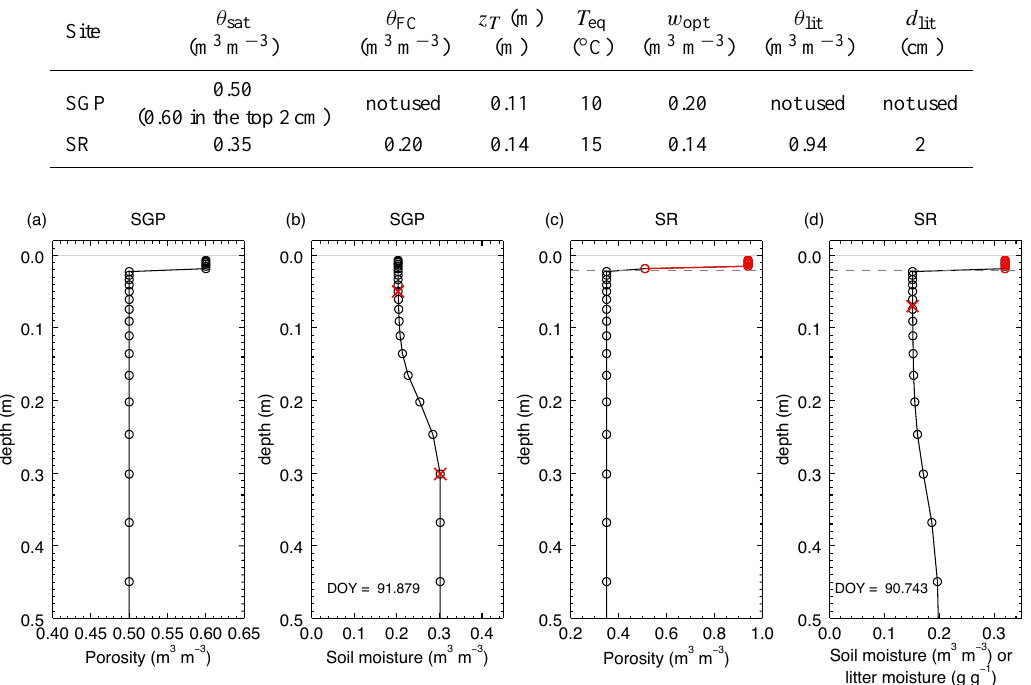
Figure 4. Soil porosity and moisture profiles at the SGP site (a, c) and the SR site (c, d) in the top 50cm. Note that in (c) and (d) , the profiles also show the porosity in the litter layers and litter water content (gg − 1 ) in red. The dashed lines denote litter–soil interfaces, and the light gray lines represent air–litter interfaces (same for Fig. 7). One computational node near litter–soil interface is interpolated for porosity in order to prevent numerical instability. Measured data of soil moisture at 5 and 30cm for SGP, and 5cm for SR, are shown as red